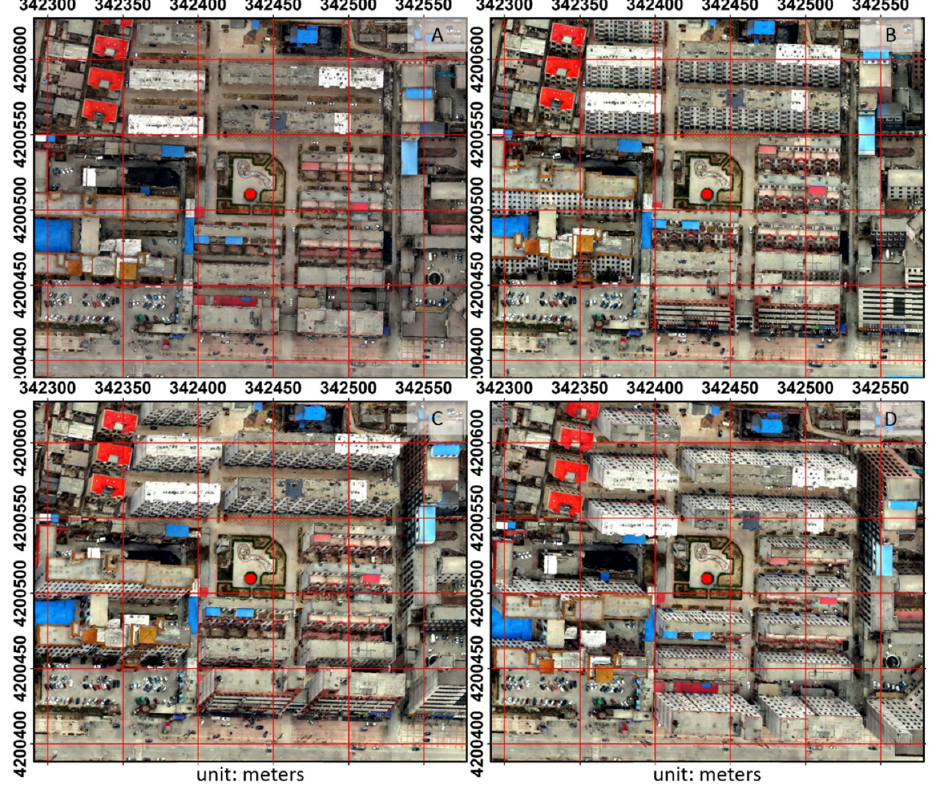
Figure 10. 2.5D maps of different perspectives created from Dataset 2 for assessing geometric accuracy: ( A ) orthographic view; ( B ) θ = 0 ◦ , ϕ = 45 ◦ ; ( C ) θ = 45 ◦ , ϕ = 45 ◦ ; ( D ) θ = 135 ◦ , ϕ = 45 ◦ .